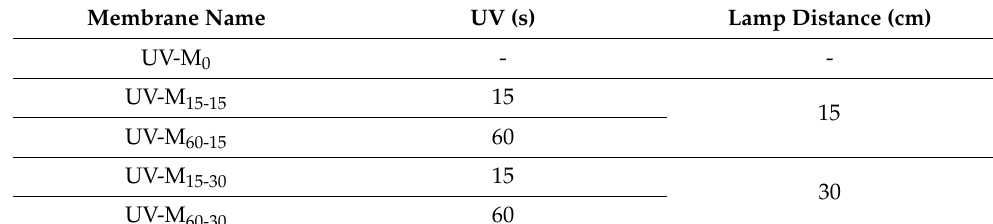
Table 1. Summary of the prepared membranes.